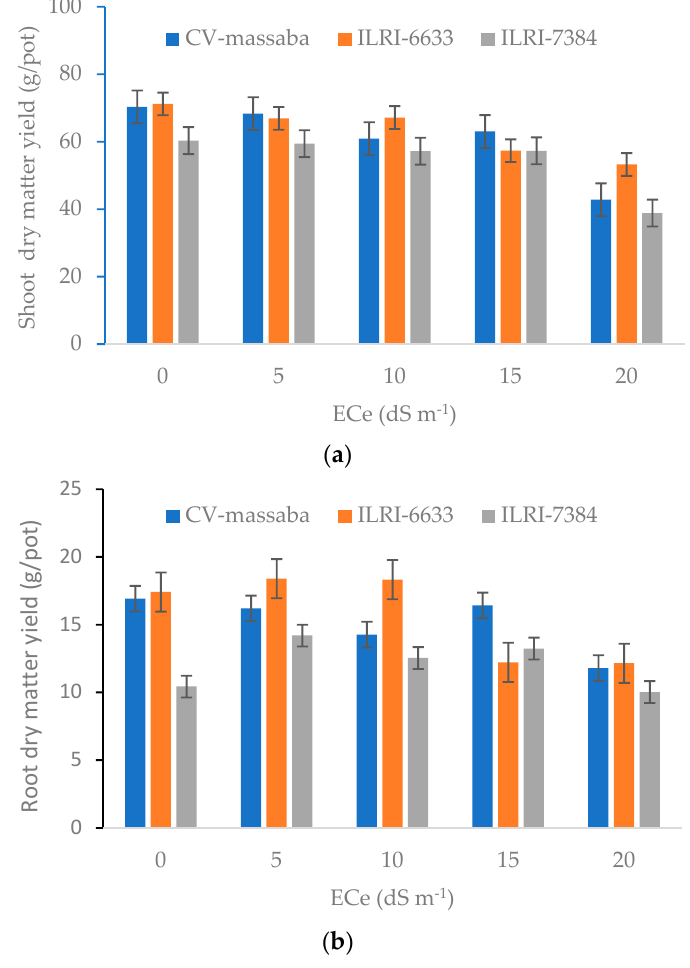
Figure 4. Effect of different salinity levels on ( a ) shoot dry matter (LSD = NS; CV = 23.75) and ( b ) root dry matter (LSD = 3.53; CV = 26.15) of three selected Chloris gayana genotypes.